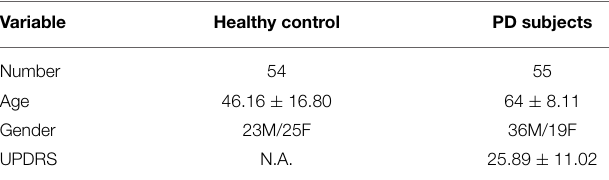
TABLE 1 | Demographics for the data in the UBC